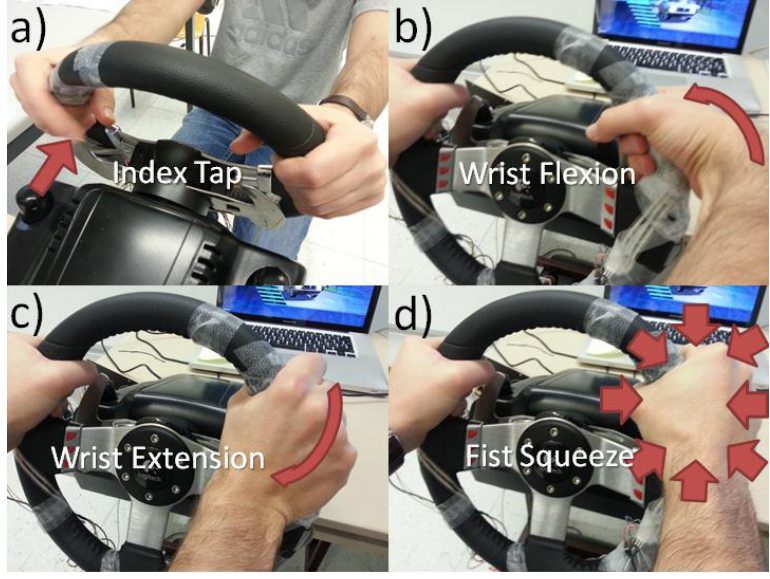
Figure 7. The four gestures for the embedded WheelSense system based on pressure